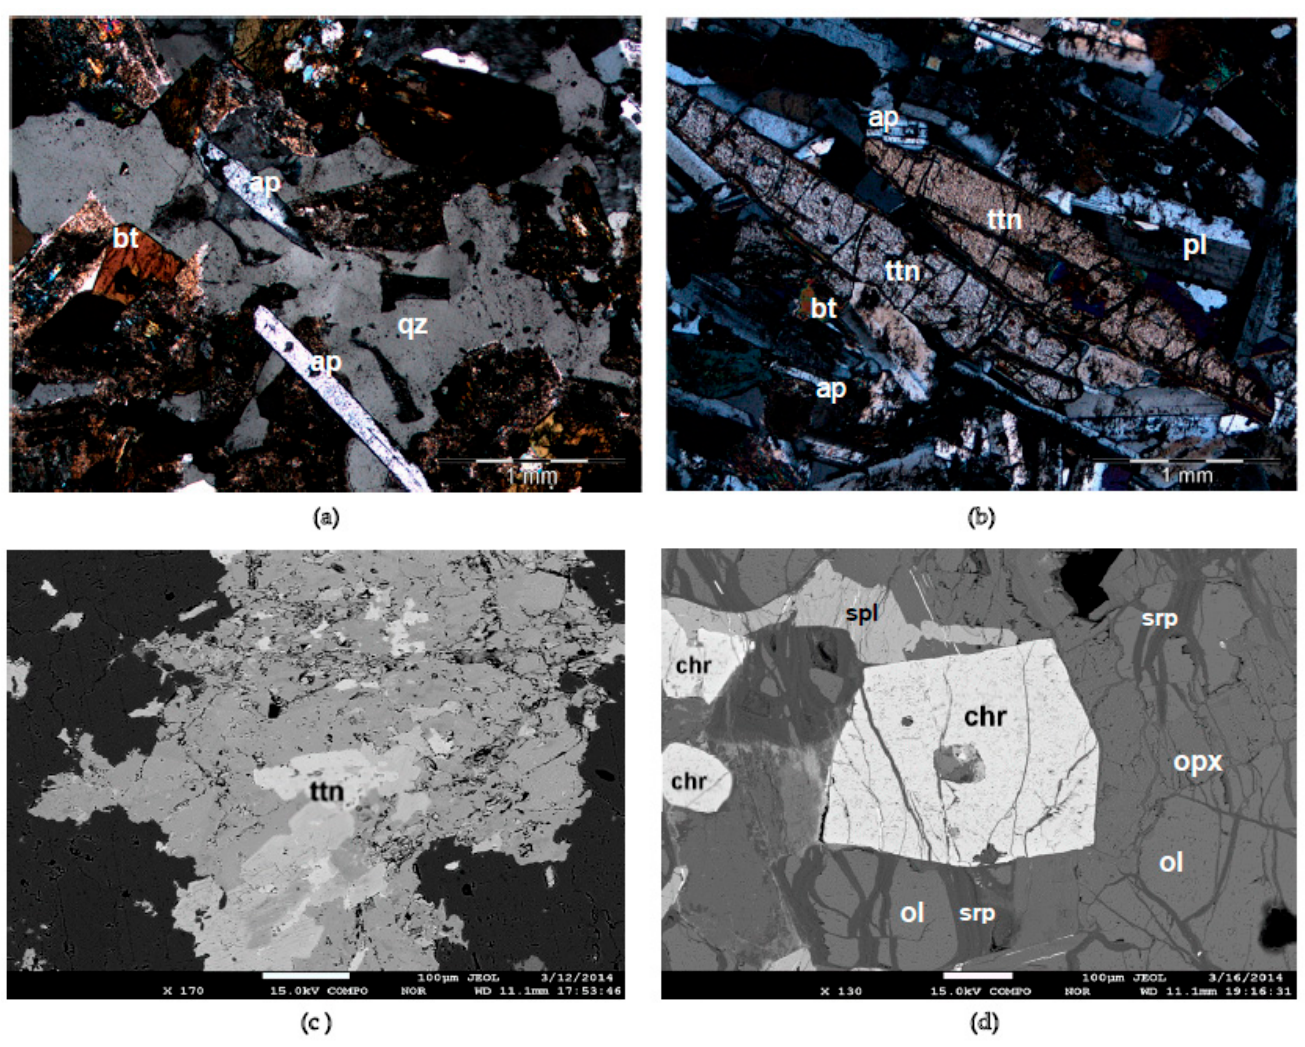
Figure A4. Plate 4. Late-stage minerals and harzburgite texture in LM-6: ( a ) MP (XPL) of apatite (ap) crystals in a quartz-gabbro of the Gabbronorite unit; ( b ) MP (XPL) of titanite (ttn) and apatite (ap) crystals in the Gabbronorite unit; ( c ) SEM-BSE image of titanite (ttn) aggregate in Gabbronorite unit; ( d ) SEM-BSE image of chromite (chr) crystal with melt inclusion and spinel (spl) in moderately serpentinized (srp) Main Harzburgite unit.